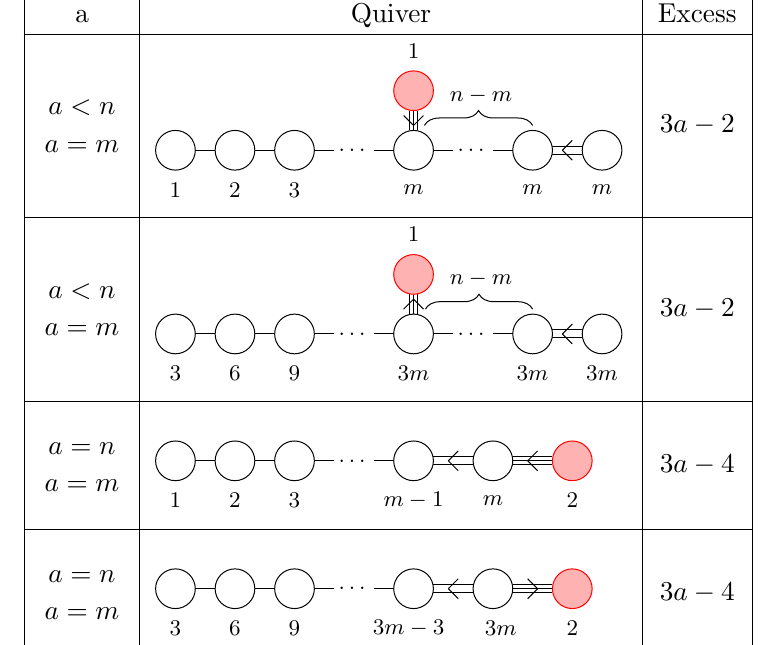
, the number of cases reduces to 6 Dynkin 6